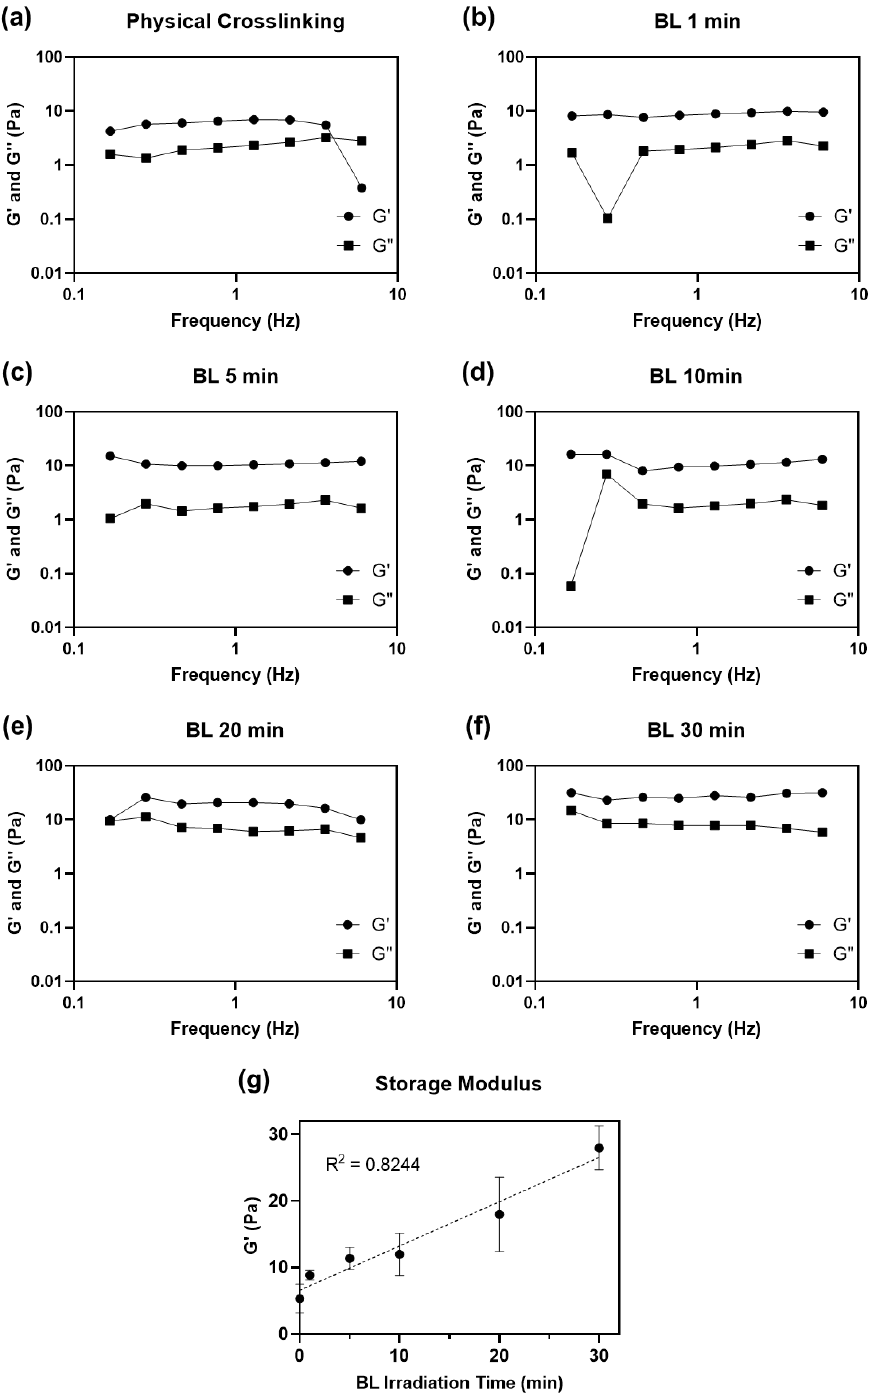
Figure 3. Dynamic moduli (G (cid:48) : storage modulus and G”: loss modulus) plotted as a function of the frequency of ( a ) physically and ( b – f ) BL-activated RFP-induced chemically crosslinked collagen hydrogel from 0.1 to 10 Hz of frequency. ( g ) Average storage moduli of crosslinked collagen hydrogel. We also evaluated the effect of irradiation time (1 to 30 min) on the mechanical properties of the hydrogels. All collagen hydrogels were incubated at 37 ◦ C for 3 h to ensure complete gelation after neutralization and irradiation steps before measuring their dynamic moduli. All collagen matrices, including physically crosslinked collagen hydrogel without BL-activated RFP, had higher storage moduli (G (cid:48) ) than loss moduli (G”), indicating that all collagen solutions formed hydrogels (Table 1). The hydrogel crosslinked